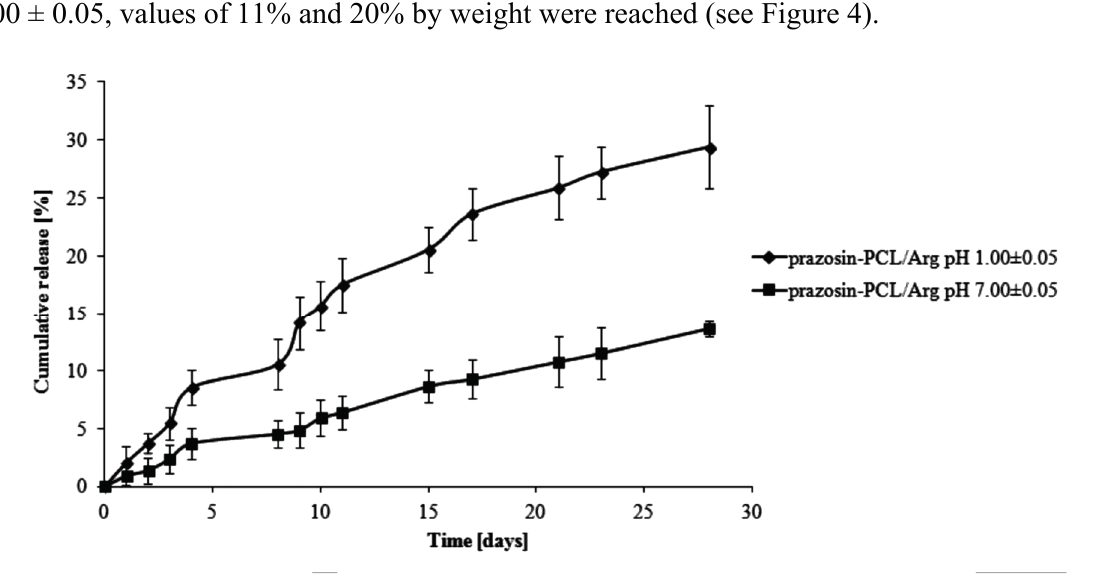
Figure 3. Release profile of prazosin from the prazosin–PCL/Arg conjugate (pH 7.00 ± 0.05 and pH 1.00 ± 0.05).